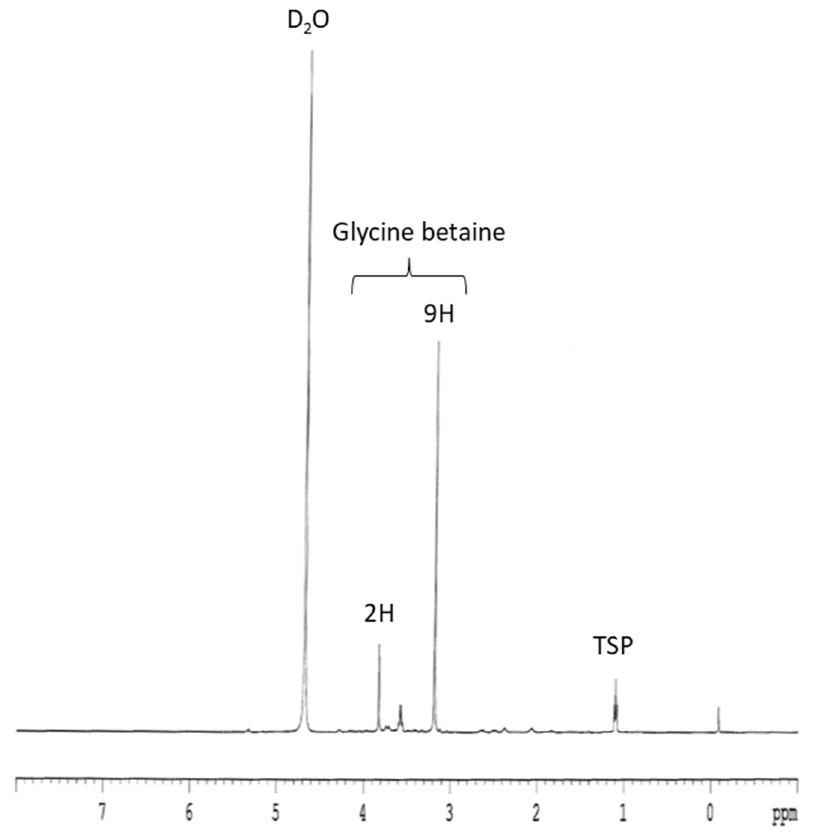
Figure 1. 1H-NMR spectrum of Salicornia europaea raw extract dissolved in D 2 O. 2 H and 9 H signals show the two main types of proton in the GB molecule (CH 2 and CH 3 , respectively). TSP, trimethylsilyl propionate.